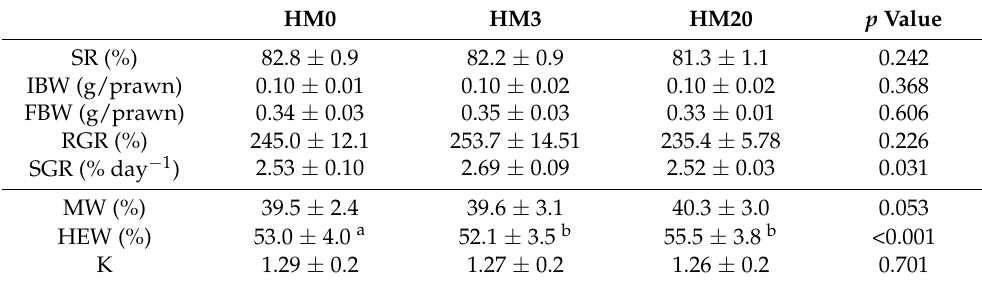
Table 4. Survival rate, growth performance, and morphological features of giant freshwater prawn fed the experimental diets post-larvae over the 60-day trial.